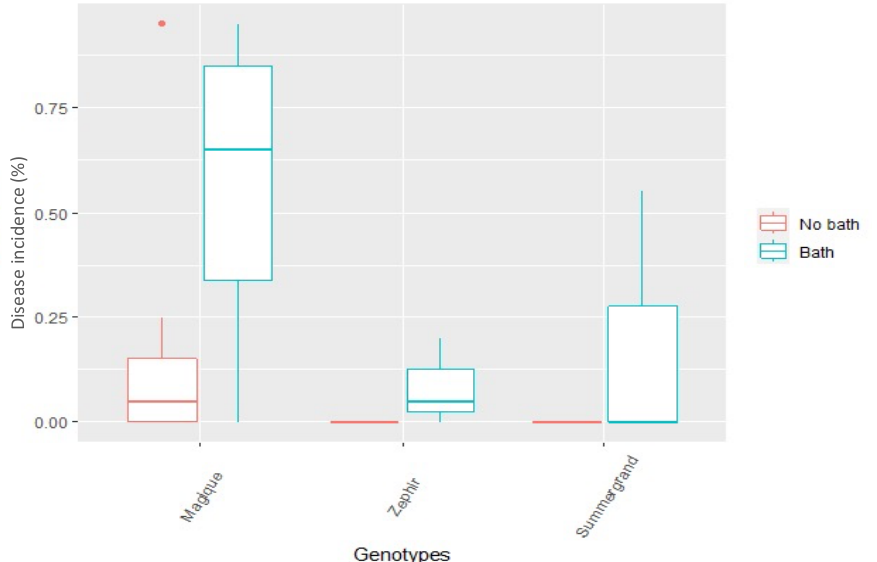
Figure 2. The effect of water bath on the brown rot disease incidence of three nectarine cultivars Magique, Zéphir, and Summergrand. Fruit were immersed in hot water (55 °C) for 45 s. The air-dried fruit at room temperature were inoculated with a 10 µL drop of M. laxa suspension at concentration 10 5 conidia mL −1 ( p -value < 0.005).